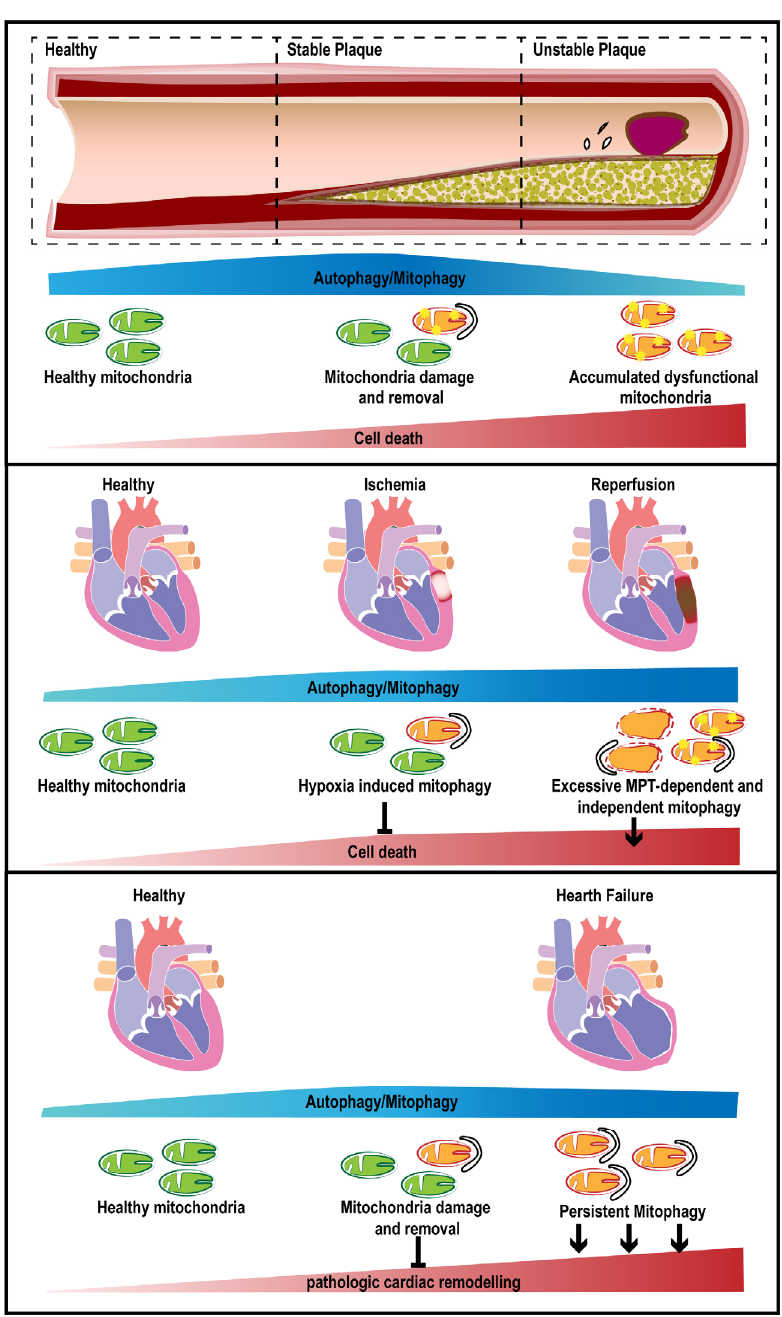
Figure 2. Involvement of mitophagy in major CVDs. Schematic representation of tissue remodeling during atherosclerosis (AS) (upper panel), I/R (middle panel) and heart failure (HF; lower panel) with related alterations in mitophagy extent, cell death or tissue remodeling. CVDs, cardiovascular diseases; I/R, ischemia/reperfusion; MPT, mitochondrial permeability transition; HF, heart failure.